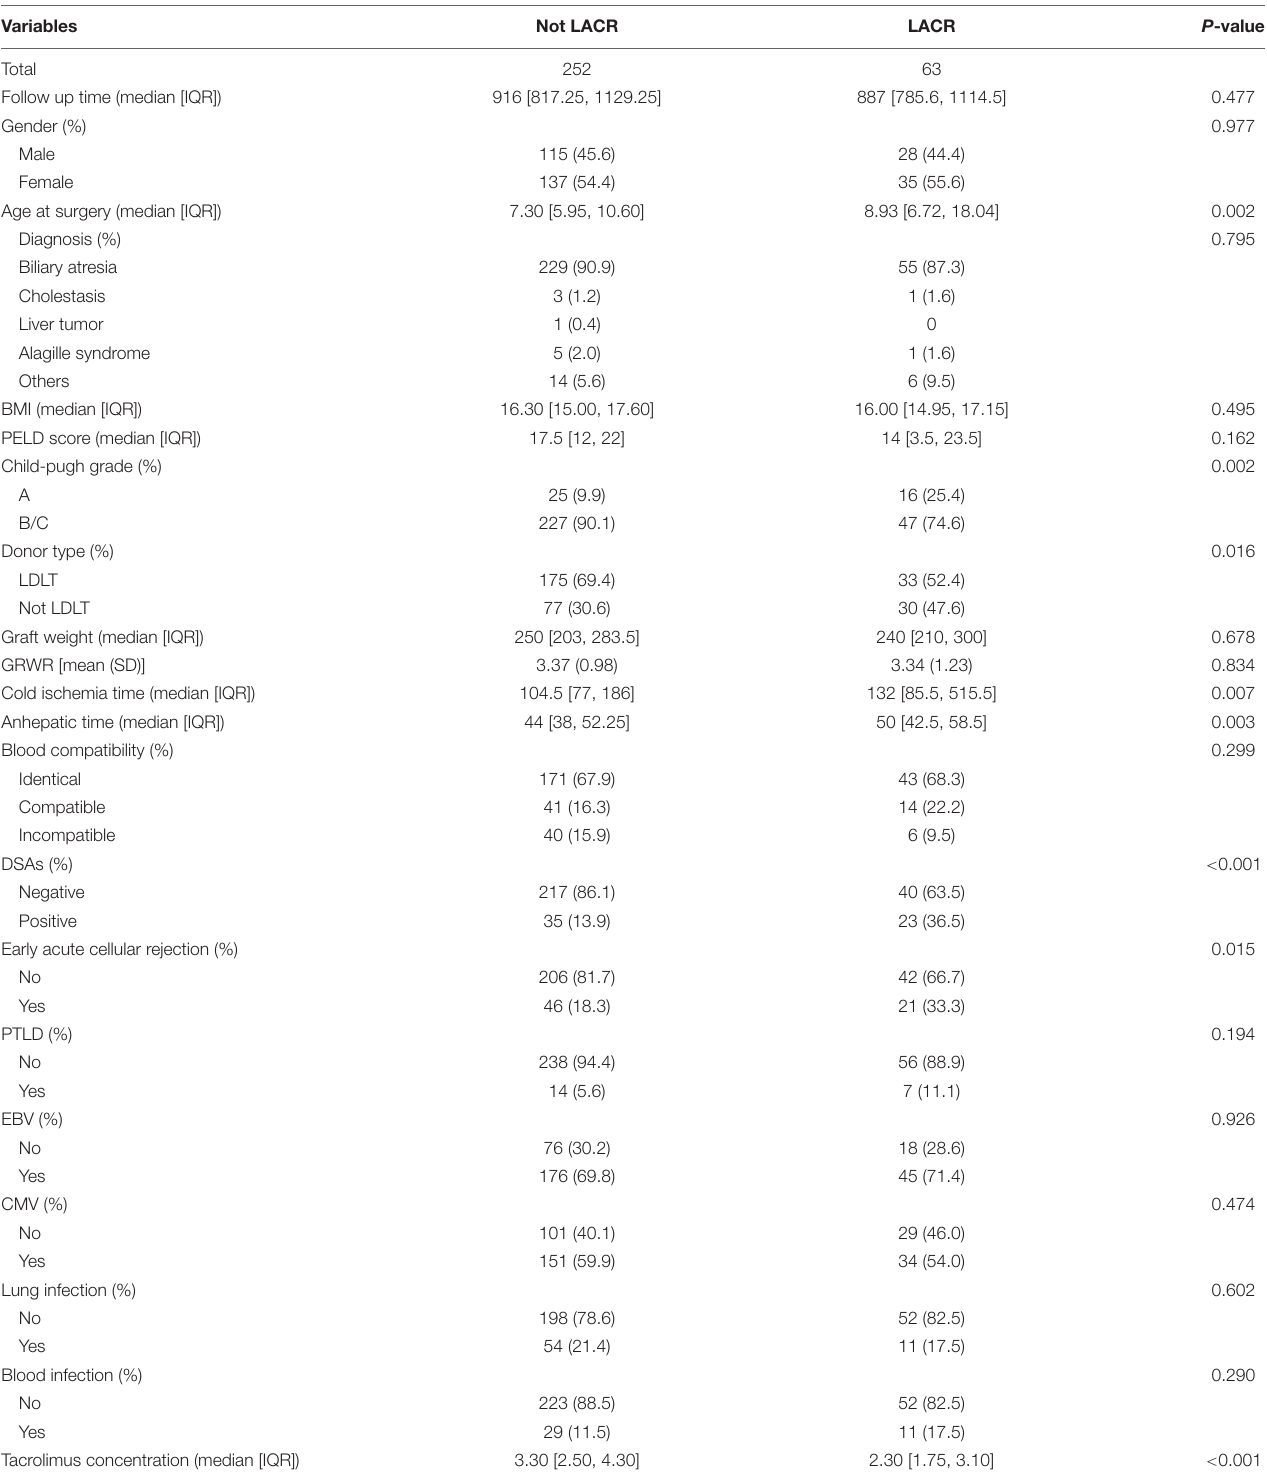
TABLE 3 | Clinical characteristics and univariable analysis of patients followed for > 2 years. Variables Not LACR